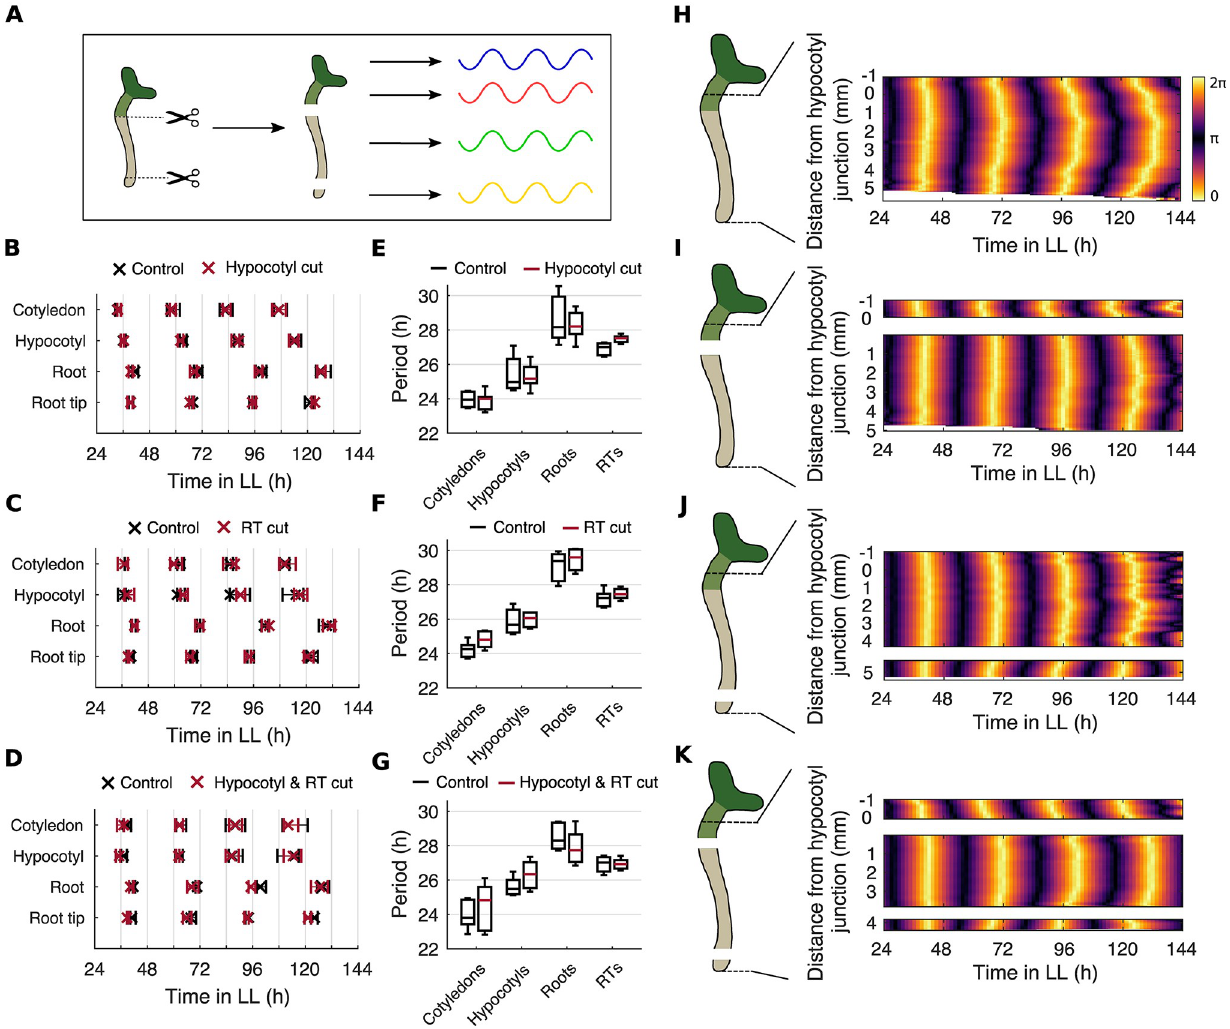
Fig 3. Spatial waves of clock gene expression persist in the absence of long-distance signals. (A) Schematic depicting the experimental design. Seedlings were cut at the hypocotyl junction, RT, or at both the hypocotyl junction and the RT. The rhythm of both the excised organs and the remaining intact organs were subsequently analyzed. (B–D) Times of peaks of GI :: LUC expression in different organs following a cut at the hypocotyl junction (B), RT (C), or both the hypocotyl junction and RT (D). Plots represent the 25th percentile, median, and the 75th percentile for the peak times of organs scored as rhythmic. (E–G) Period estimates of GI :: LUC for different organs following a cut at the hypocotyl junction (E), RT (F), and both the hypocotyl junction and RT (G). All comparisons of means are not significantly different, p > 0.05, by two-tailed t test, Welch correction. Box plots indicate the median and upper and lower quartiles, and whiskers the 9th and 91st percentiles of organs scored as rhythmic. (H–K) Representative phase plot of GI :: LUC expression across longitudinal sections of the hypocotyl and root of a single seedling without a cut (H) or with a cut at either the hypocotyl junction (I), RT (J), or both the hypocotyl junction and RT (K). Schematics show the approximate cut position and the region analyzed. Color maps are as in H. For hypocotyl cut experiments, N = 4; RT cut, N = 3; hypocotyl and RT cut, N = 3. For all, n = 9–17. N represents the number of independent experiments and n the total number of organs tracked. See S1 and S2 Files for exact n , test statistics, and percentage rhythmicity of each organ. Underlying data are available from https://gitlab.com/slcu/teamJL/greenwood_etal_2019. GI , GIGANTEA ; LL, constant light; LUC , LUCIFERASE ; RT, root tip.